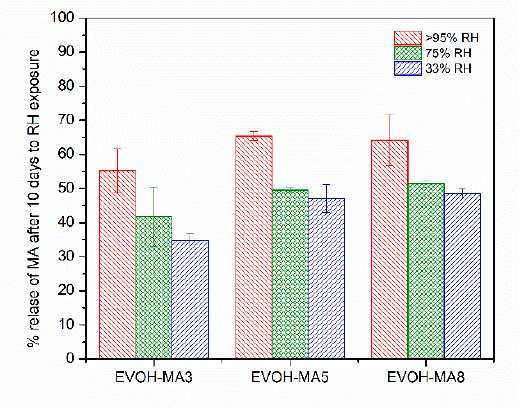
Figure 7. Methyl anthranilate release from EVOH based films after 10 days influenced by relative humidity (33, 75 and >95%).